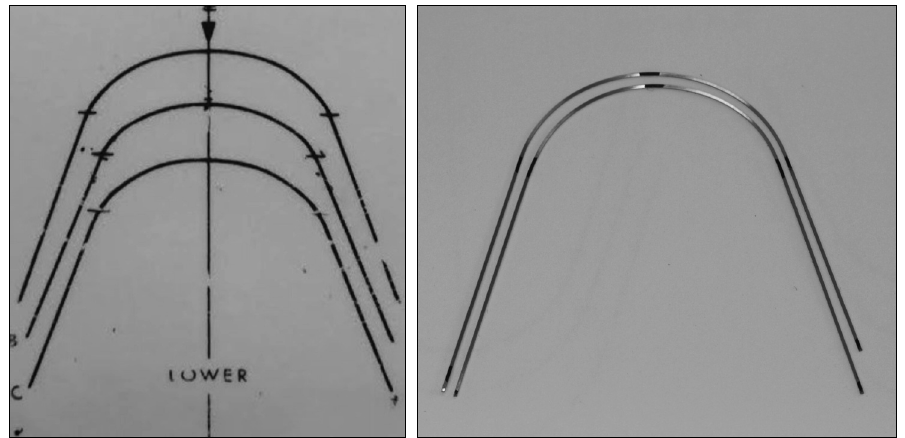
Figure 1. Arch form template (3M Unitek, CA, USA) and upper and lower archwires with the lower wire bent to the middle arch form on that